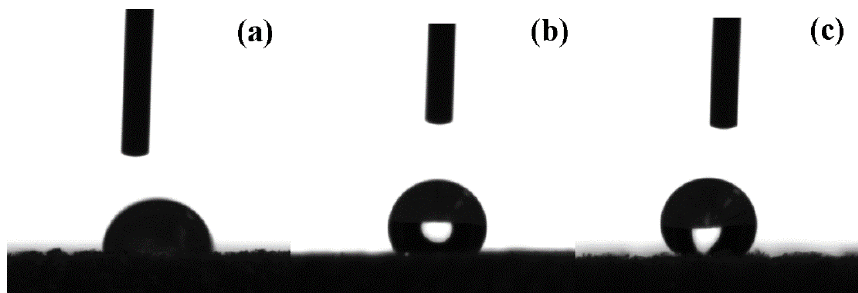
Figure 8. Water contact angles of ( a ) original wood, ( b ) UW, and ( c ) VW.